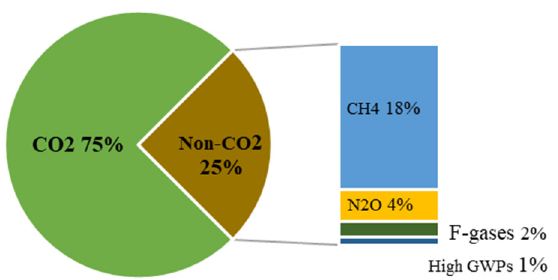
Figure 1. Contribution of CO 2 and non-CO 2 greenhouse gas emissions in 2021 (W/m 2